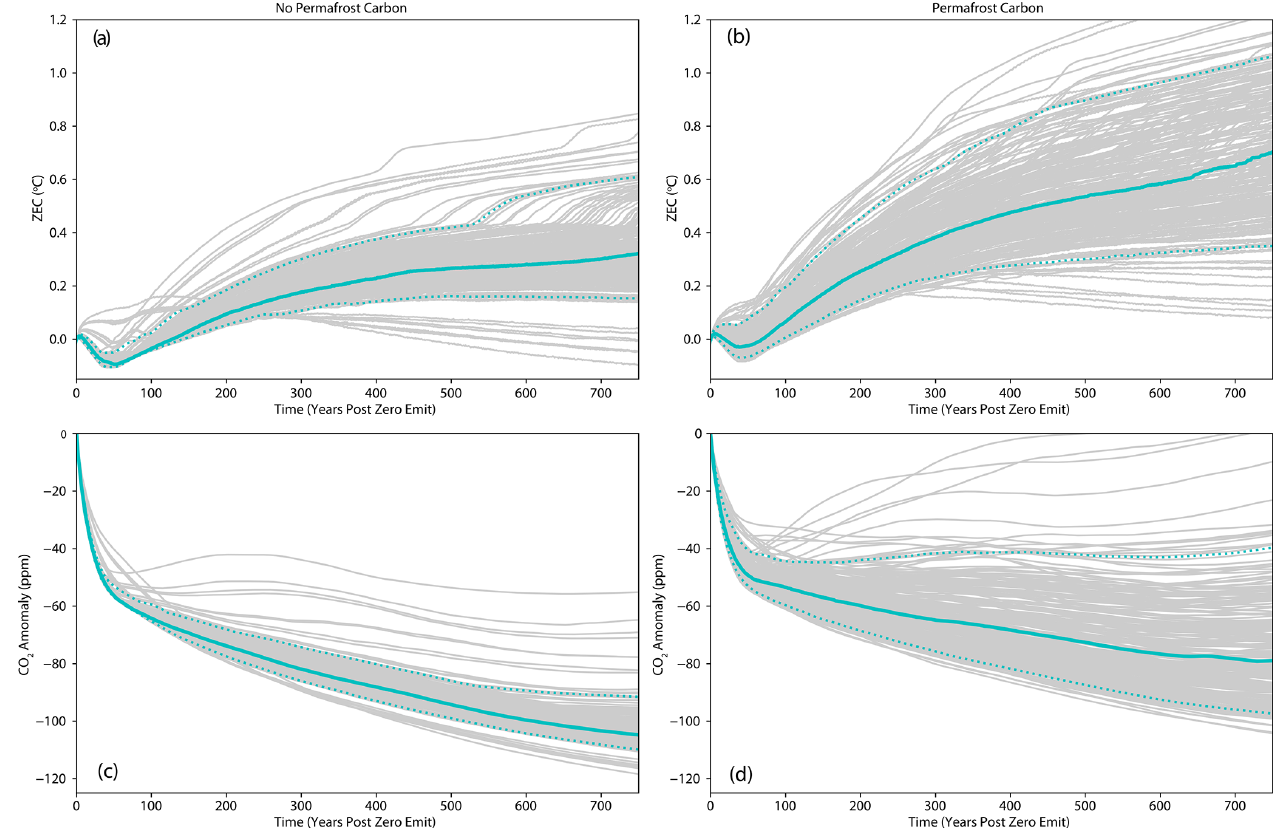
Figure 3. (a, b) Zero Emission Commitment (ZEC) for model versions without (a) and with (b) a permafrost carbon pool forced by the A1 (1000PgC) experiment. ZEC is temperature change relative to the year emissions cease. (c, d) Change in atmospheric CO 2 concentration relative to year emissions cease for model versions without (c) and with (d) a permafrost carbon pool, forced by the A1 (1000PgC) exper- iment. Grey lines are individual model variants, solid line is the median of the variants, and dashed lines are the 5th and 95th percentile. Sudden increase in warming rate seen in many warmer model variants is associated with the disappearance of perennial sea ice in the Weddell and Ross seas and concurrent changes in overturning circulation.